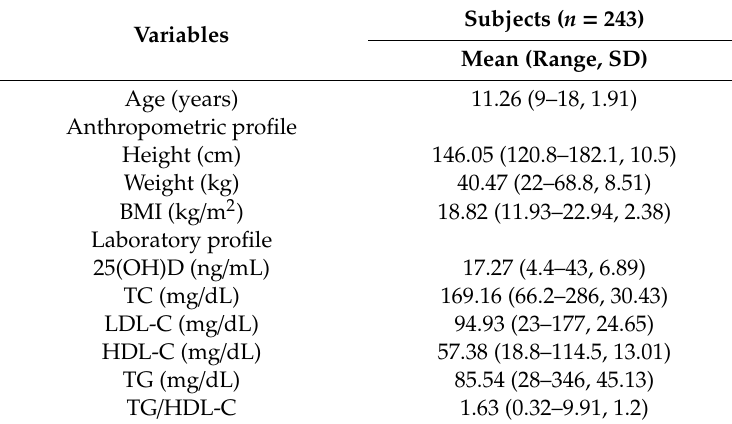
Table 1. Subject